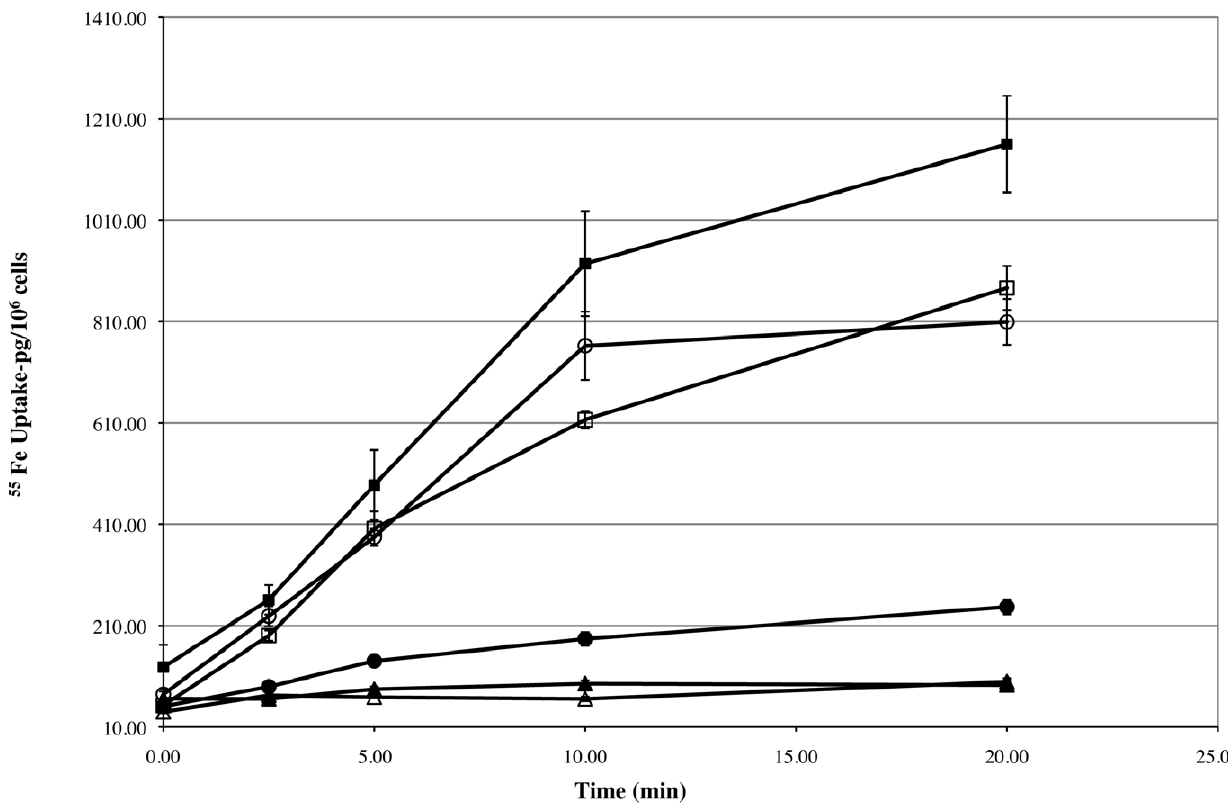
N , # ); and corynebactin utilization deficient